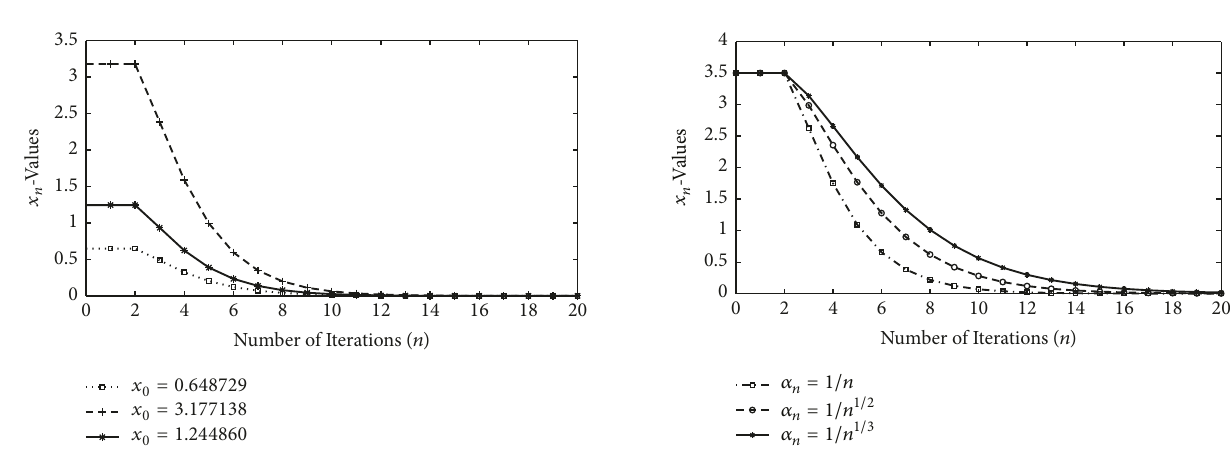
Figure 1: The comparison of convergent rate from 3 initial points. Figure 2: The comparison of convergent rate from 3 different alpha parameters.